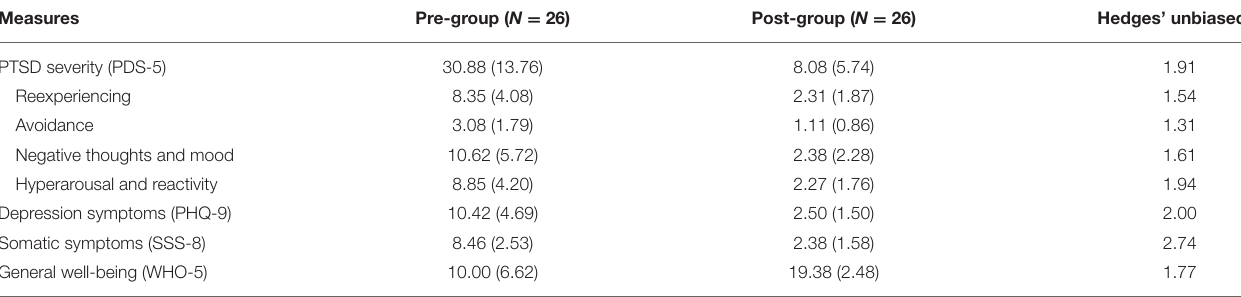
TABLE 1 | Pre and post group measures of psychopathology and